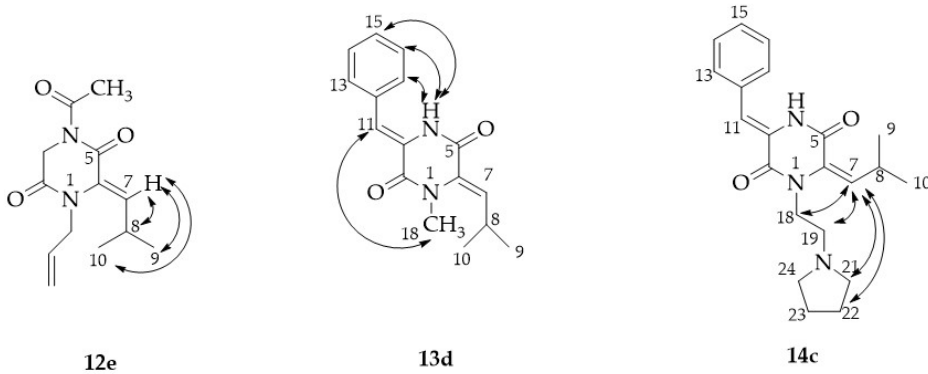
Figure 2. NOEDIFF and NOE contracts for stereoisomers of compounds 12e , 13d , and 14c .